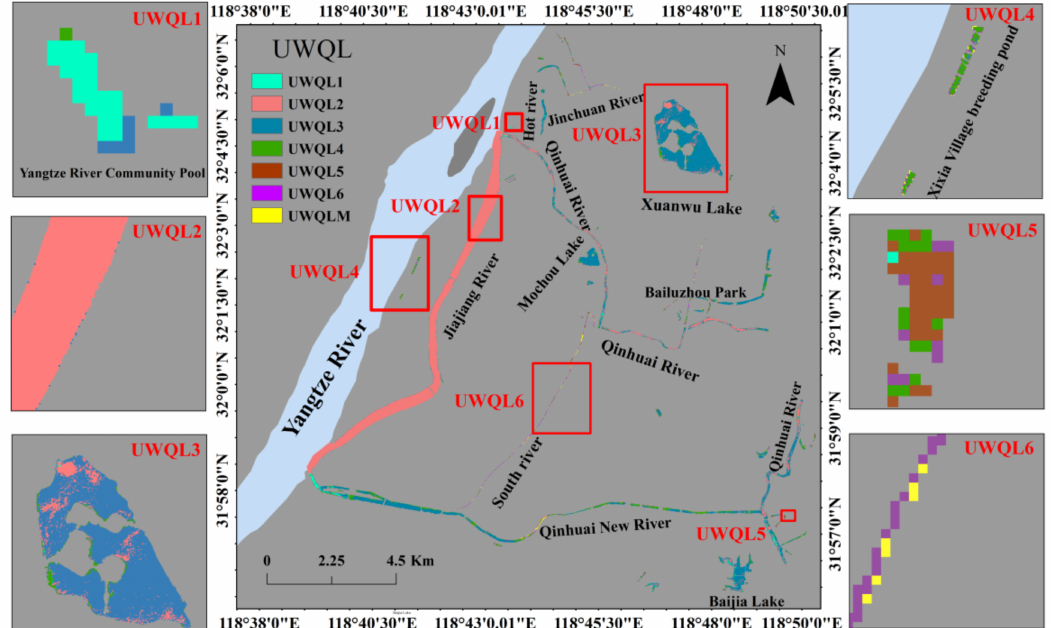
Figure 6. Results of urban water quality levels based on Sentinel-2 MSI of the built-up area of Nanjing on 19 July 2017. UWQL1–UWQL6: the six typical water areas of